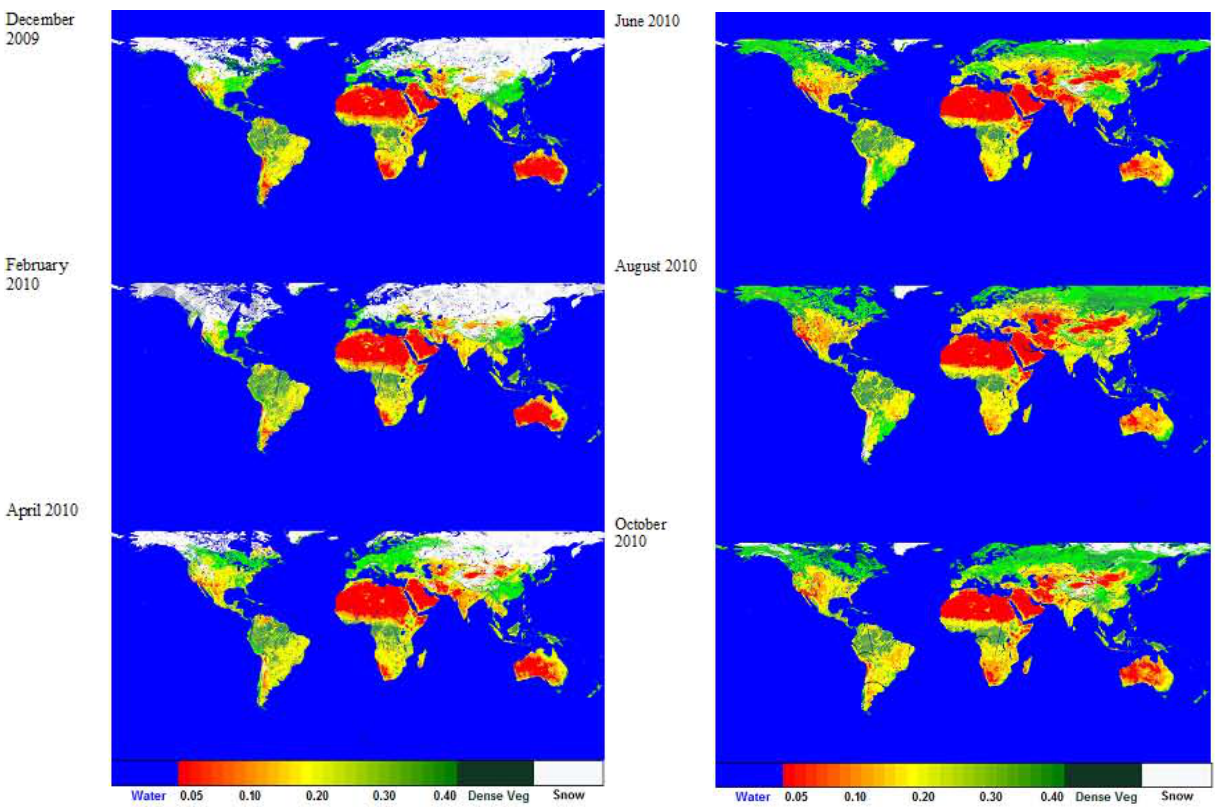
Fig. 12. (a) SMC maps (in m 3 m − 3 ) of the entire world obtained in December 2009, February and April 2010, by using HydroAlgo. Some AMSR-E scans are missing, as we can see in Africa and North America in February 2010. (b) SMC maps (in m 3 m − 3 ) of the entire world obtained in June, August, and October 2010, by using HydroAlgo. Some AMSR-E scans are missing, as we can see in Africa and South America (black